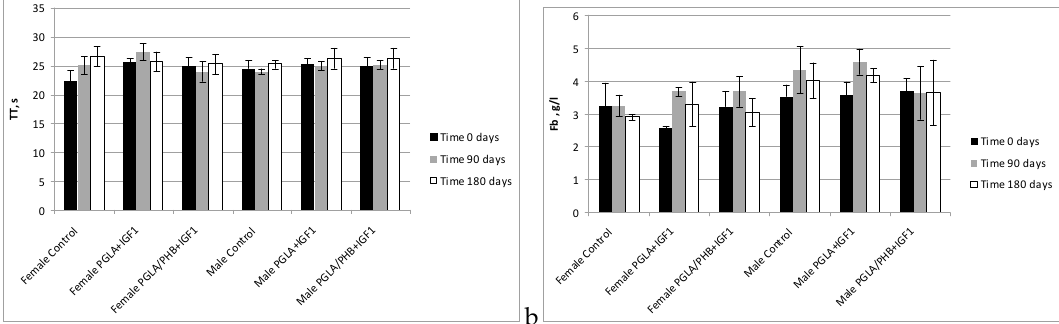
Figure 9. Activated partial thromboplastin time (APTT) ( a ) and prothrombin time (PT) ( b ) of blood of rabbits. Figure 10. Thrombin time (TT) ( a ) and concentration fibrinogen (Fb) ( b ) of blood of rabbits.